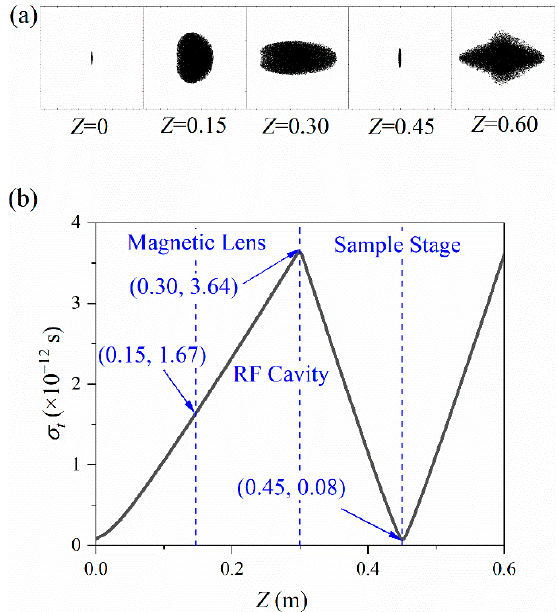
Figure 3. Longitudinal shape ( a ) and pulse duration 𝜎 (cid:3047) ( b ) evolve during propagation.